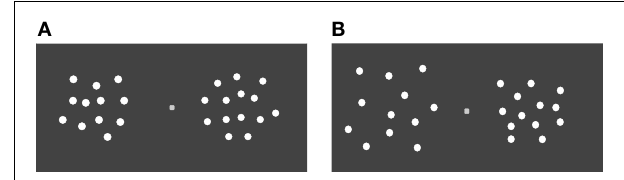
FIGURE 5 | Schematic view of stimuli in (A) the control and (B) the large array area